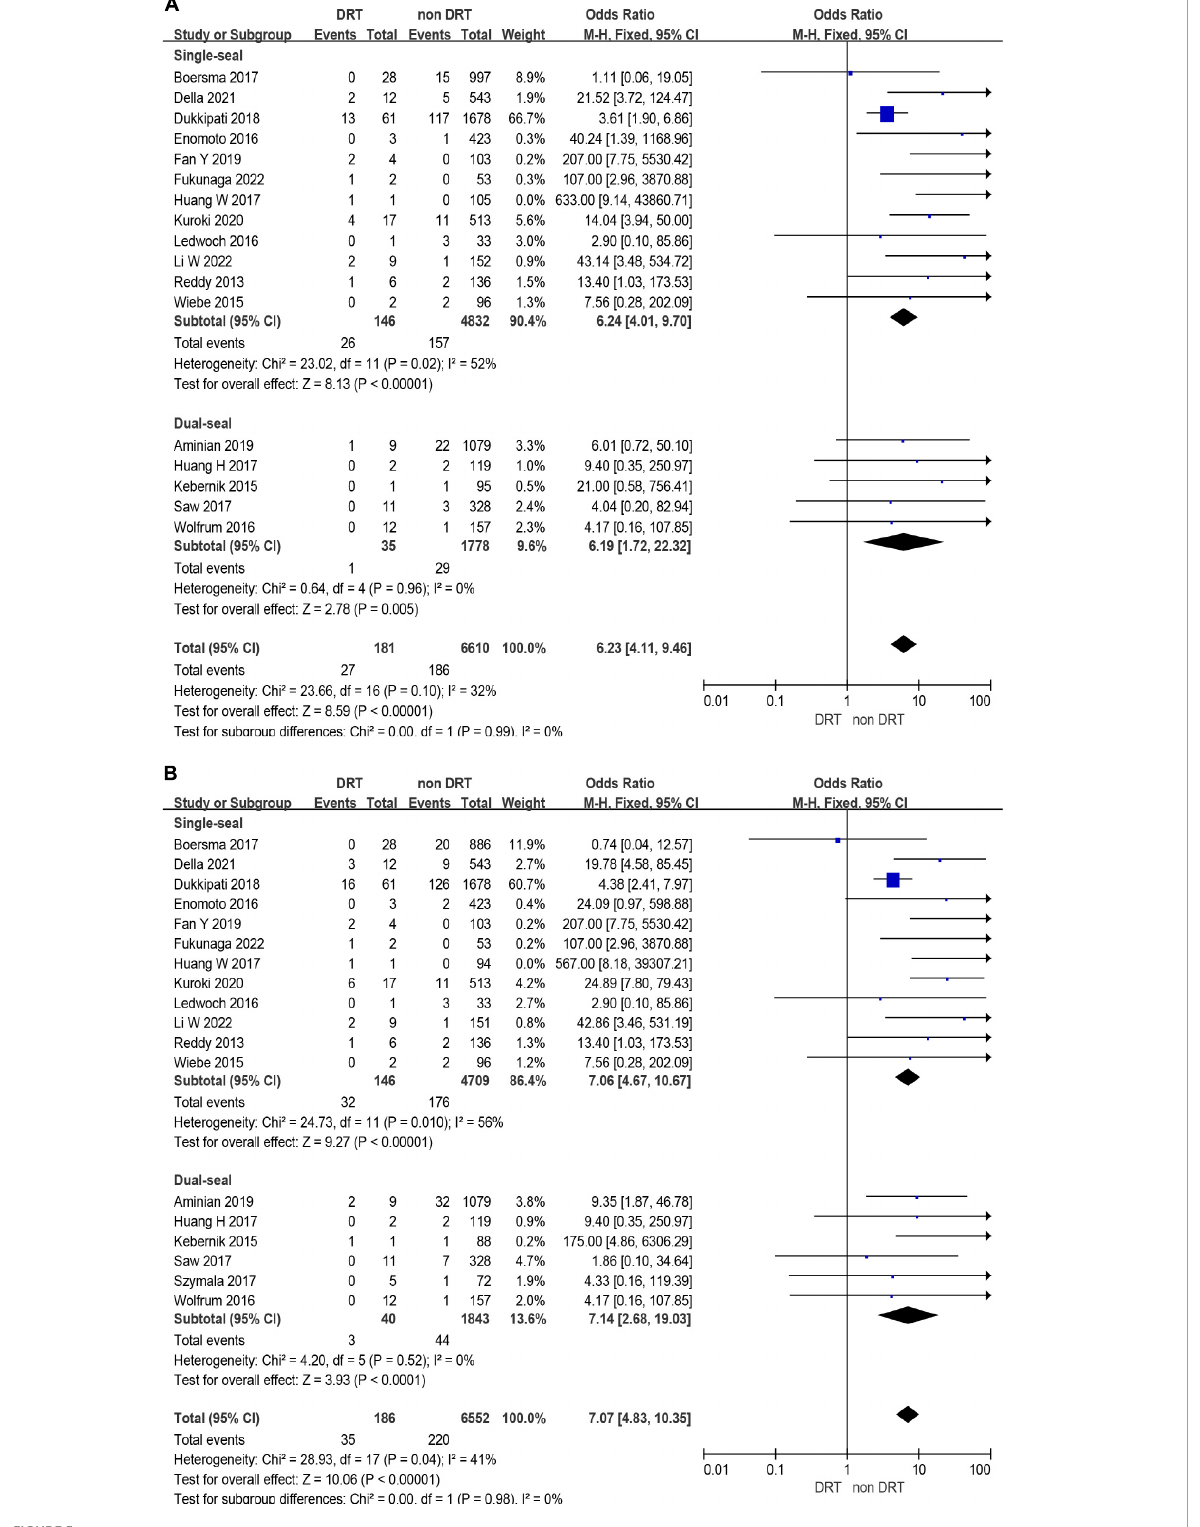
FIGURE5 Forest plots of stroke (A) and systemic embolism (SE) (B) in device related thrombus (DRT) and non-DRT patients with subgroup analysis based on occlusion